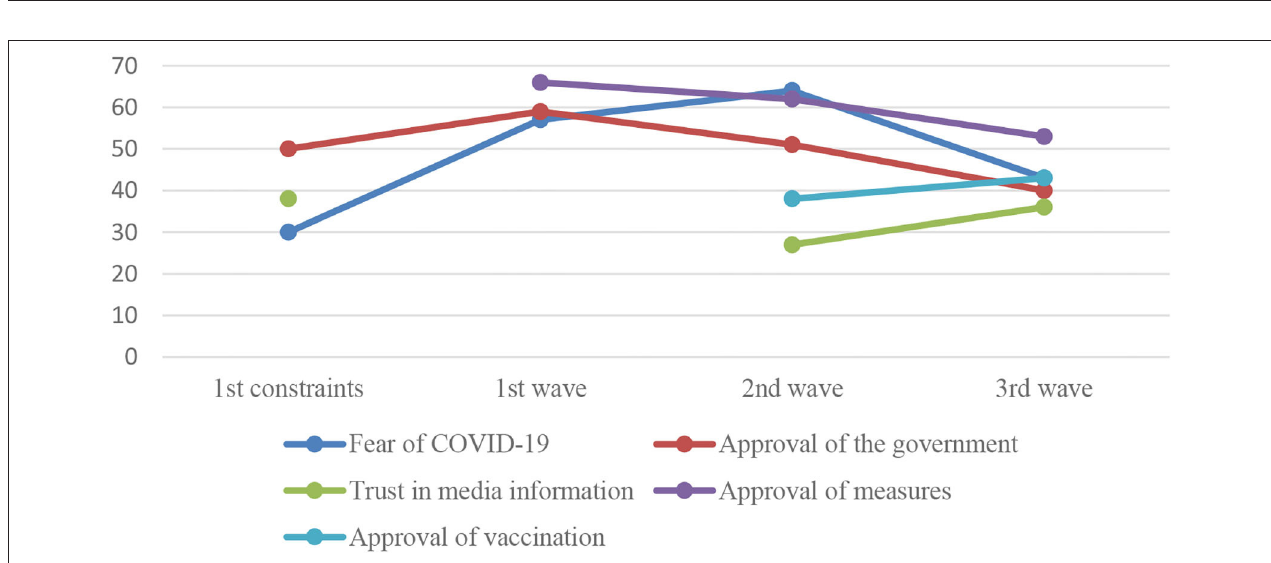
FIGURE 1 | Distribution of media mechanisms over the study periods (number of cases).